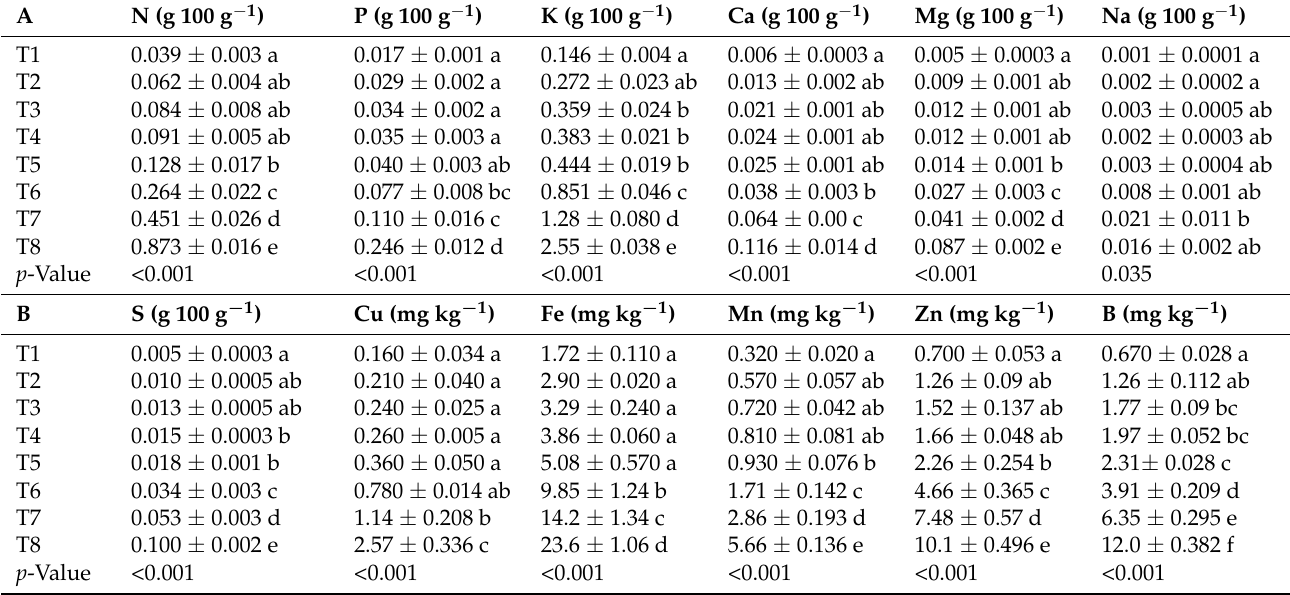
Table 5. Nutrient concentration in fruit of tomato plants receiving UWP treatments (T1–T7) and the Hoagland’s control